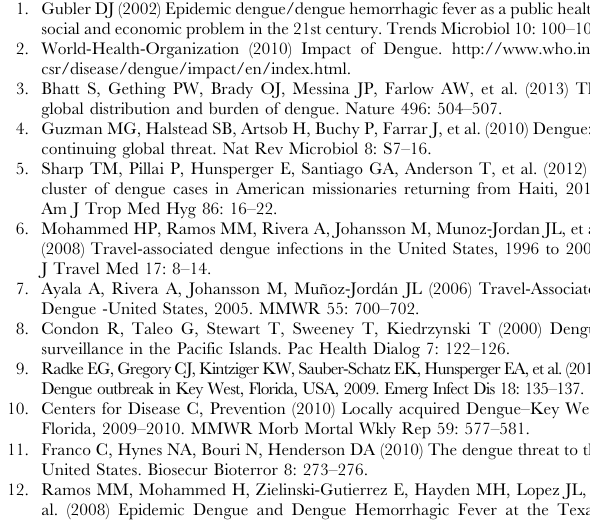
error bars indicate standard deviation. Dashed line shows the threshold of positivity at CT= 37.